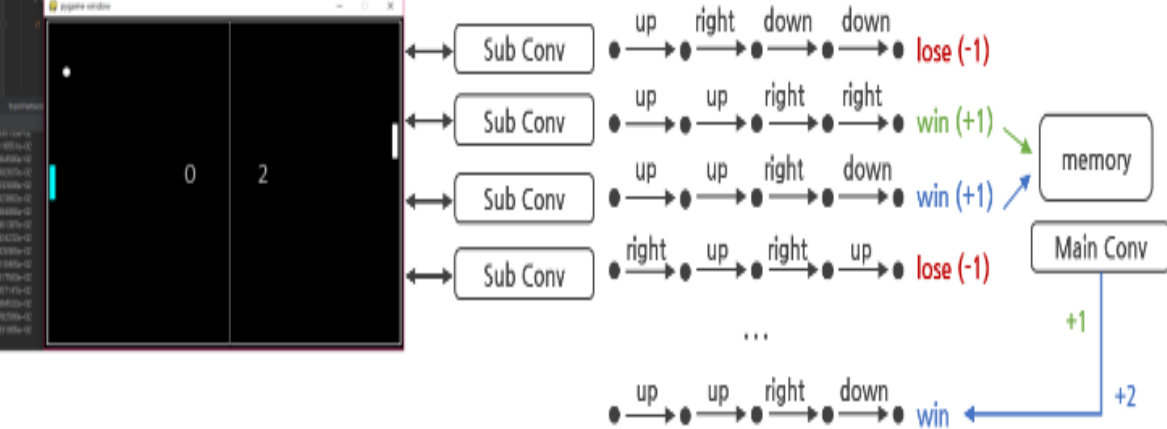
Figure 14. Visualization of the ping-pong game through reinforcement learning.